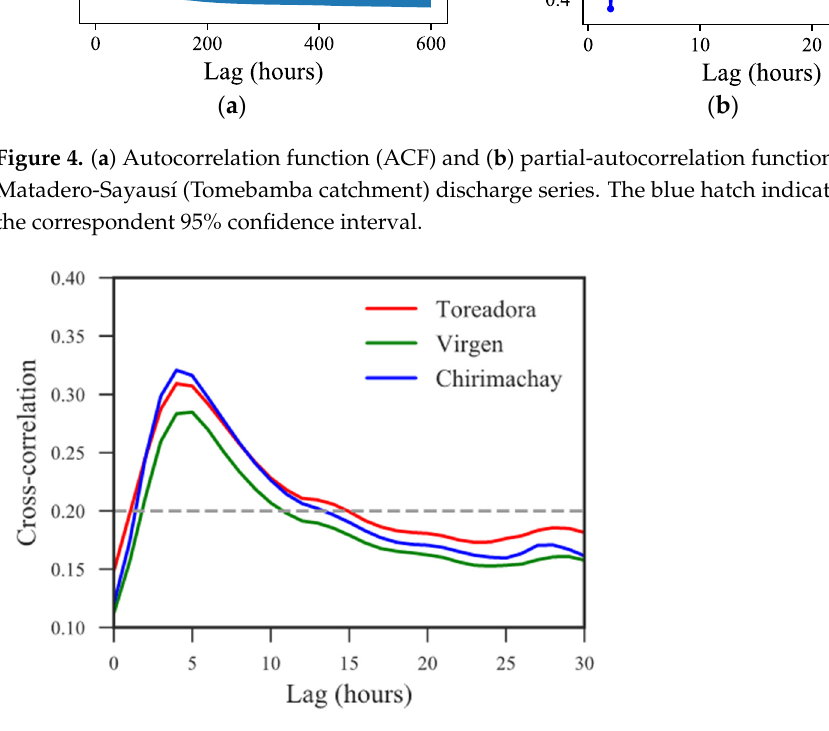
Figure 4. ( a ) Autocorrelation function (ACF) and ( b ) partial-autocorrelation function (PACF) of the Matadero-Sayausí (Tomebamba catchment) discharge series. The blue hatch indicates in each case the correspondent 95% confidence interval.